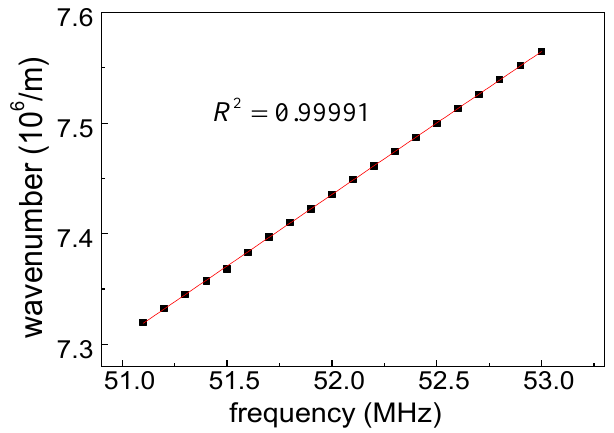
Figure 3. Linear relationship between radio frequency (RF) and the wavenumber of an electro-optic swept source based on the AOTF.